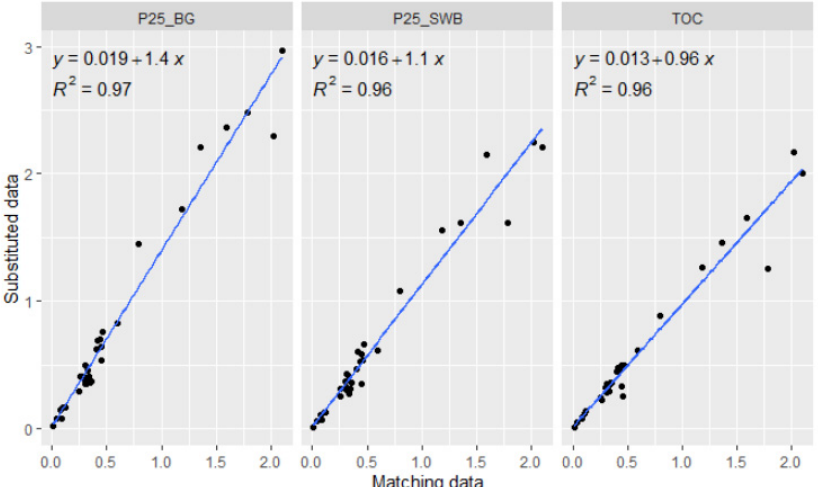
Figure 7. The comparison of the BIO-MET calculated RCR for Zn between the matching data and substituted data (P25_BG—the 25th percentile of the available DOC data and/or the DOC data cal- culated by the TOC from the Bulgarian monitoring network results during 2020; P25_SWB—the 25th percentile of the DOC data calculated by the TOC for the respective water body; TOC—the matching DOC data calculated by TOC).